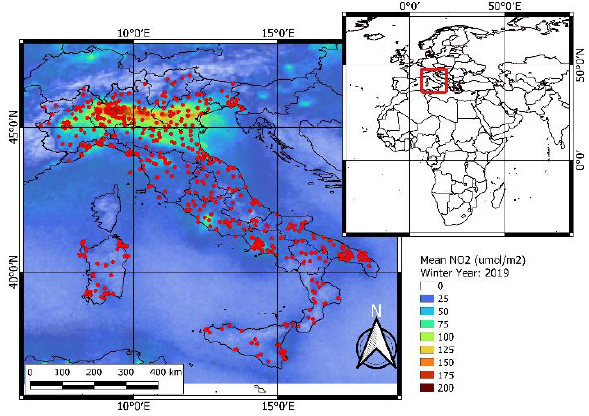
Figure 2. Study area with ground